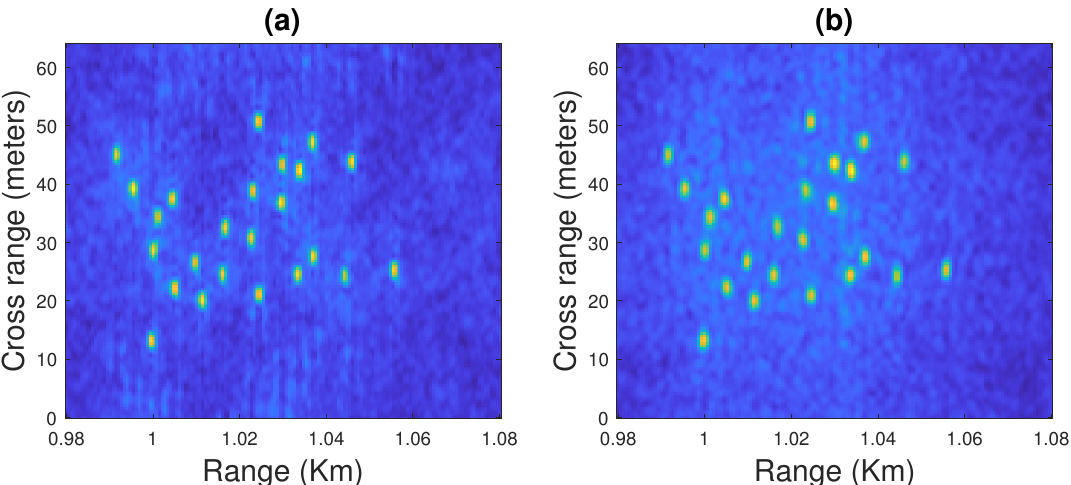
Figure 12. Signature analysis of the complex target obtained using ( a ) the Lorenz CBFM waveform and ( b ) the Burke–Shaw CBFM